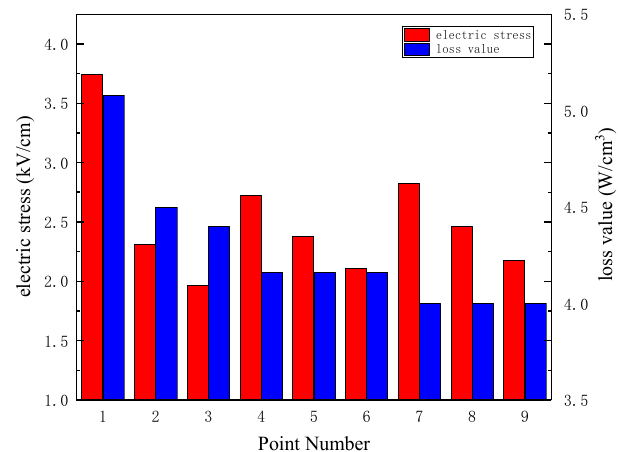
Figure 15. Maximum electric stress and loss versus various values of the nonlinear coefficient of the corona protection layer.